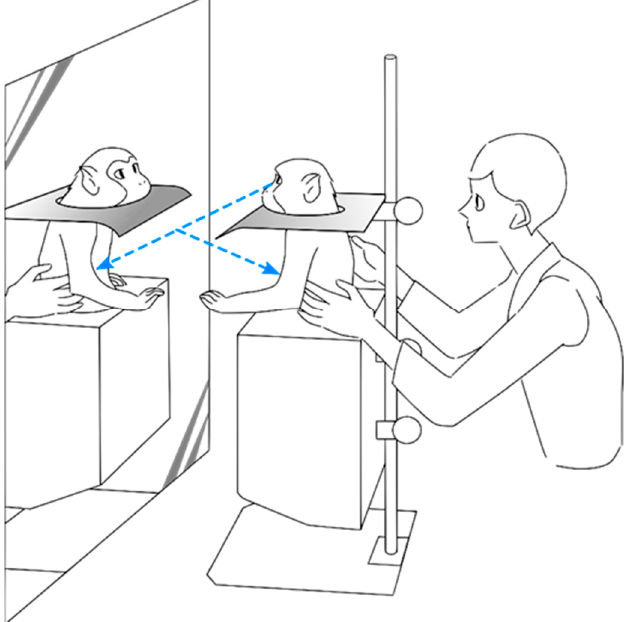
Figure 1. Experimental setup used during the experiment. The animal sat in a monkey chair that neither covered the upper body nor restricted upper limb movement. A full-body mirror was placed in front of the animal. When needed, an opaque plate could be placed to ensure that the animal was not able to view her own body directly, but only through the mirror reflection. not able to view her own body directly, but only through the mirror